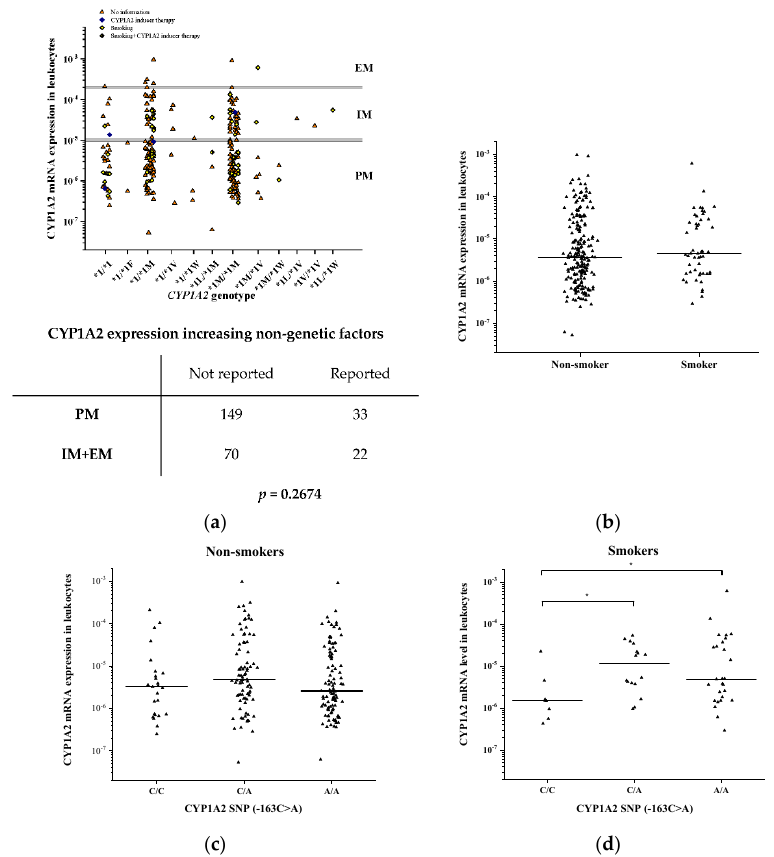
Figure 4. The effect of genetic and non-genetic factors on CYP1A2 expression in the leukocytes of patients with psychiatric disorders: The impact of CYP1A2 genetic variations and non-genetic factors (CYP1A2-inducer therapy, smoking) on CYP1A2 expression ( a ) and the influence of smoking on mRNA expression ( b – d ) are presented. The horizontal lines display the median values. The table provides the number of subjects in various metabolizer groups with the information of relevant non-genetic factors. Abbreviations: PM, poor metabolizer; IM, intermediate metabolizer; EM, normal metabolizer; * p < 0.05.